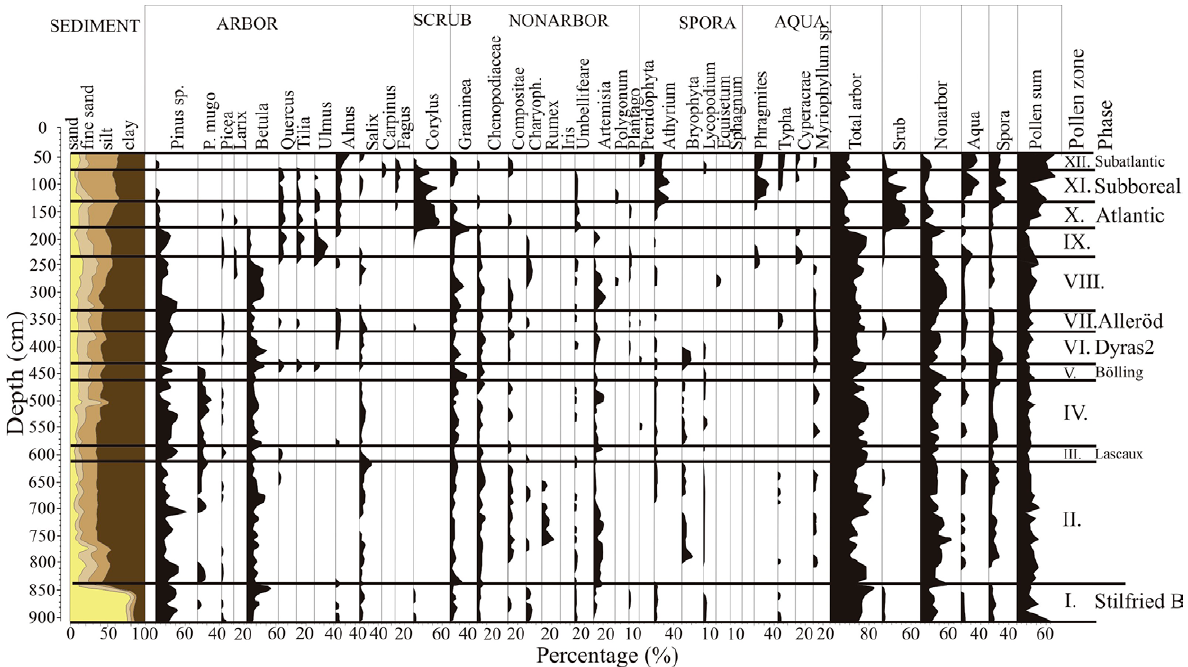
Figure 5. Sediment and pollen profile of the P1 paleo-channel, representing a paleo-channel in a back-swamp area between alluvial